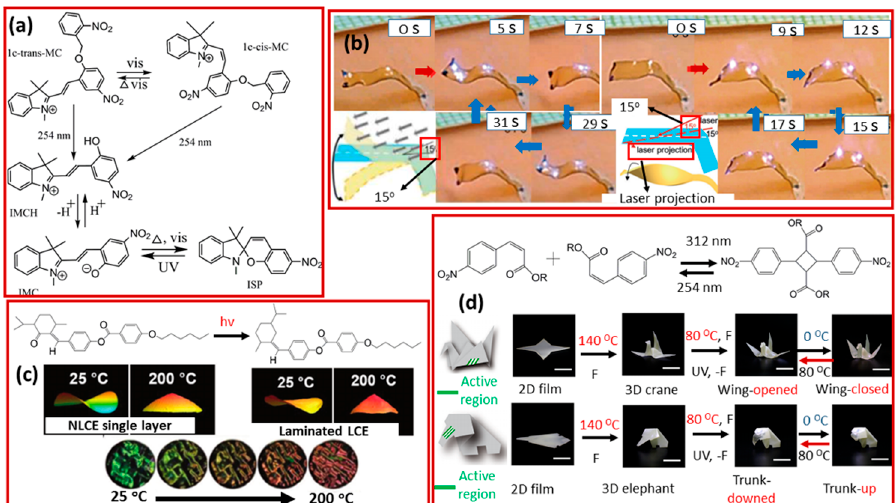
Figure 8. ( a ) Spiropyran-based molecular switch and the UV-vis absorption spectra in response to different stimuli (Reprinted (adapted) from https://pubs.acs.org/doi/10.1021/jacs.8b09523). ( b ) Chemical structure of the liquid crystal elastomer containing 2-butyloctyl carbon chains and autonomous arm-like motions of the strip actuator under constant illumination of a laser (Reprinted (adapted) with permission [110]. Copyright (2012) John Wiley and Sons). ( c ) The photo-isomerization of the chiral olefin and the deformation and color change of the LCE layer when heated from 25 to 200 ◦ C (Reprinted (adapted) with permission [111]. Copyright (2019) John Wiley and Sons) [70]. ( d ) Photo-reversible dimerization of nitro-cinnamate and typical model to illustrate the light programming (Reprinted (adapted) from Science Advances, Applied Sciences and Engineering [112]. Copyright (2018), American Association for the advancement of